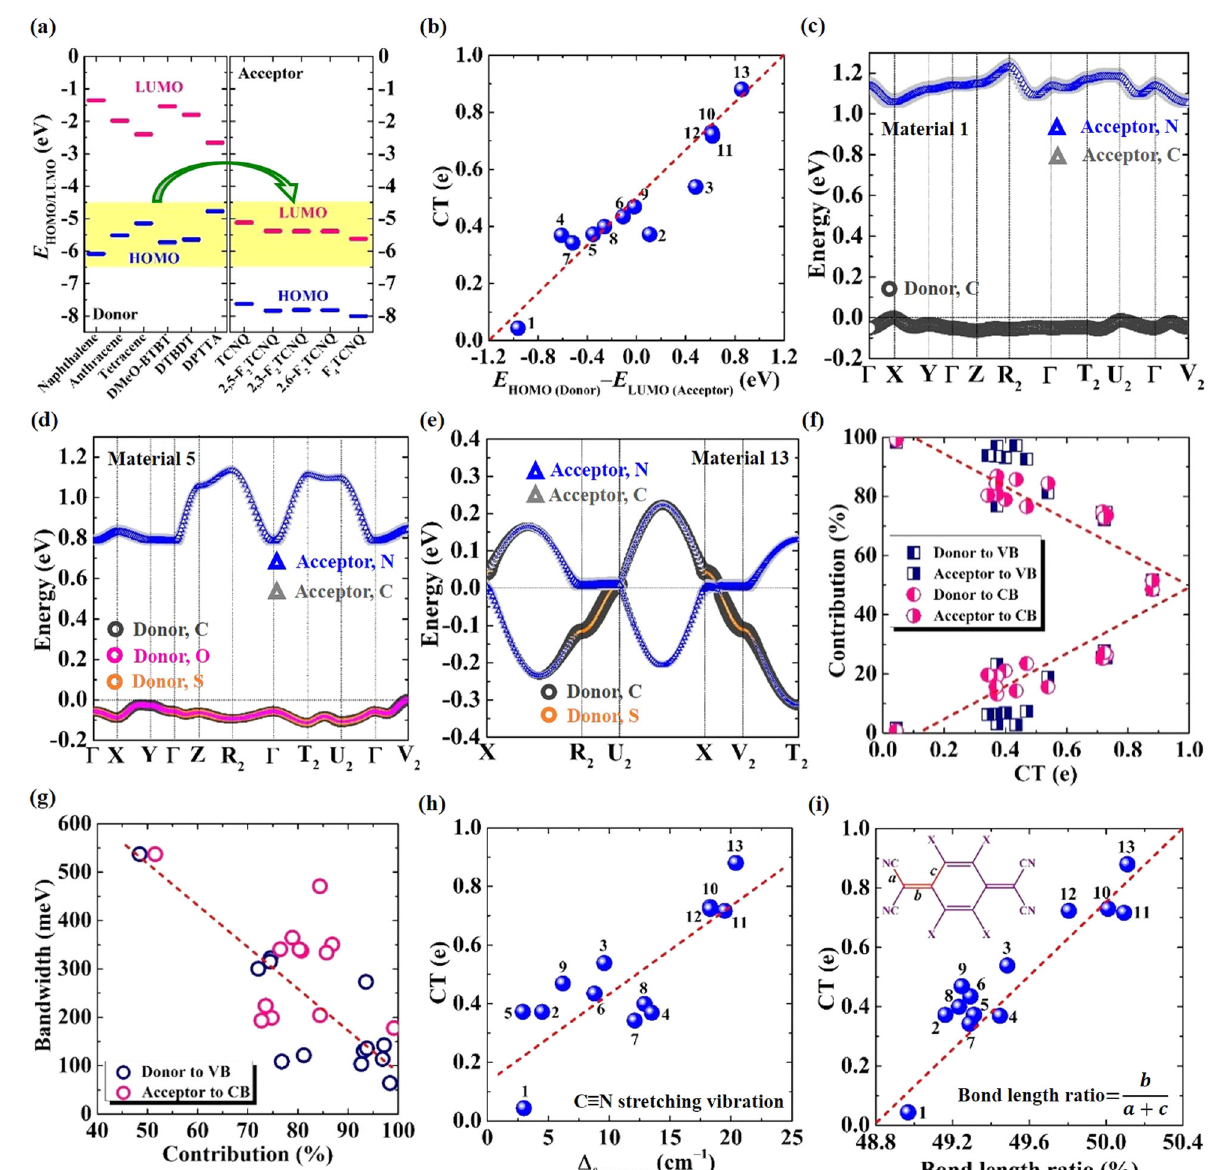
Fig. 3 General correlations among molecular structure, energy level, charge transfer, and electronic structure. a The HOMO (blue) and LUMO (magenta) energy level ( E HOMO = LUMO ) for our studied isolated donor and acceptor molecules. b The relationship between the charge transfer (CT) and the energy-level difference ( E HOMO ð Donor Þ (cid:2) E LUMO ð Acceptor Þ , where E HOMO ð Donor Þ and E LUMO ð Acceptor Þ are the HOMO energy level of donor and LUMO energy level of acceptor, respectively.). The red dashed line shows the trend. c – e The orbital projected band structures for (naphthalene)(TCNQ) ( 1 ), (DMeO-BTBT)(2,5-F 2 TCNQ) ( 5 ), and (DPTTA)(F 4 TCNQ) ( 13 ), respectively. The symbol size denotes the relative weight of the component ratio. The reciprocal coordinates of high-symmetry k -points in the fi rst Brillouin zone are Γ = (0, 0, 0), X = (0.5, 0, 0), Y = (0, 0.5, 0), Z = (0, 0, 0.5), R 2 = ( − 0.5, − 0.5, 0.5), T 2 = (0, − 0.5, 0.5), U 2 = ( − 0.5, 0, 0.5), and V 2 = (0.5, − 0.5, 0), respectively. The carbon, oxygen, and sulfur atoms in the donor molecules are shown in open gray circle, open pink circle, and open orange circle, respectively; the nitrogen and carbon atoms in the acceptor molecules are shown in open blue triangle and open gray triangle, respectively. The orbital projected band structures for other materials are shown in Supplementary Fig. 3. f The relationship between the contributions of donor and acceptor to valence band (VB) and conduction band (CB), and the charge transfer (CT). The red dashed line shows the trend. g The relationship between the bandwidth and the contributions of donor to VB, and those of acceptor to CB. The red dashed line shows the trend. h The relationship between the charge transfer (CT) and the shift of C ≡ N stretch i ng vibrational frequency in acceptor ( Δ frequency ). The red dashed line shows the trend. i The relationship between the charge transfer (CT) and the bond length ratio in acceptor. The de fi nition of bond length ratio is given in the inset. The red dashed line displays the